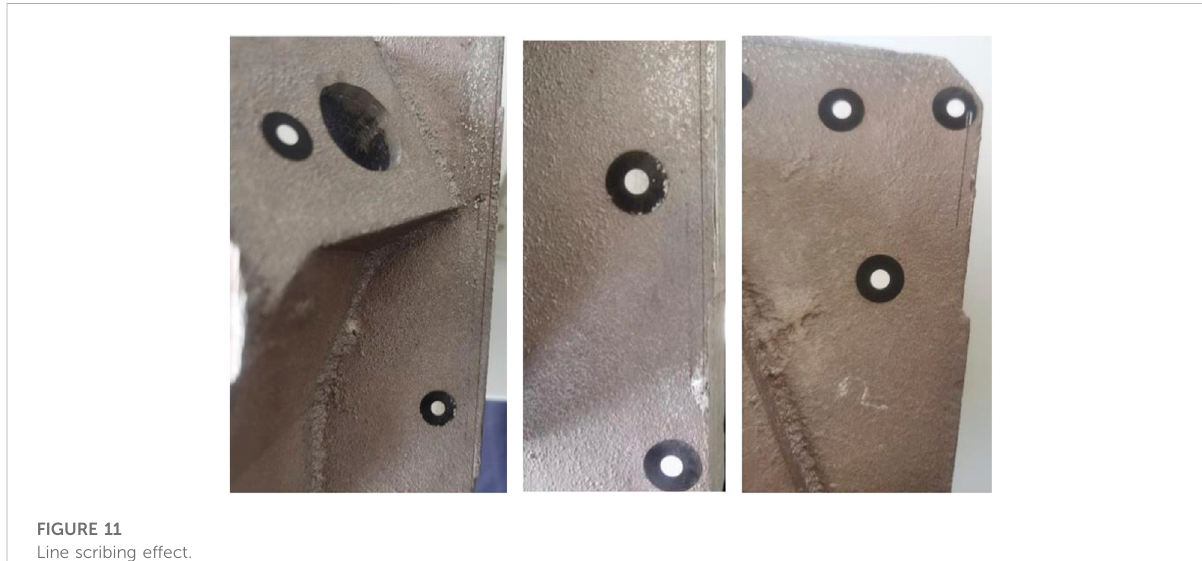
FIGURE 11 Line scribing